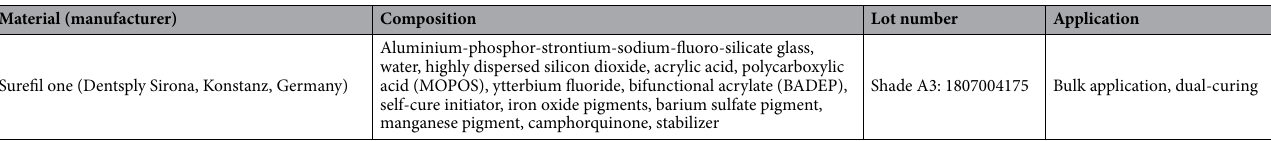
Table 2. Composition of the self-adhesive bulk-fill restorative as per manufacturer.